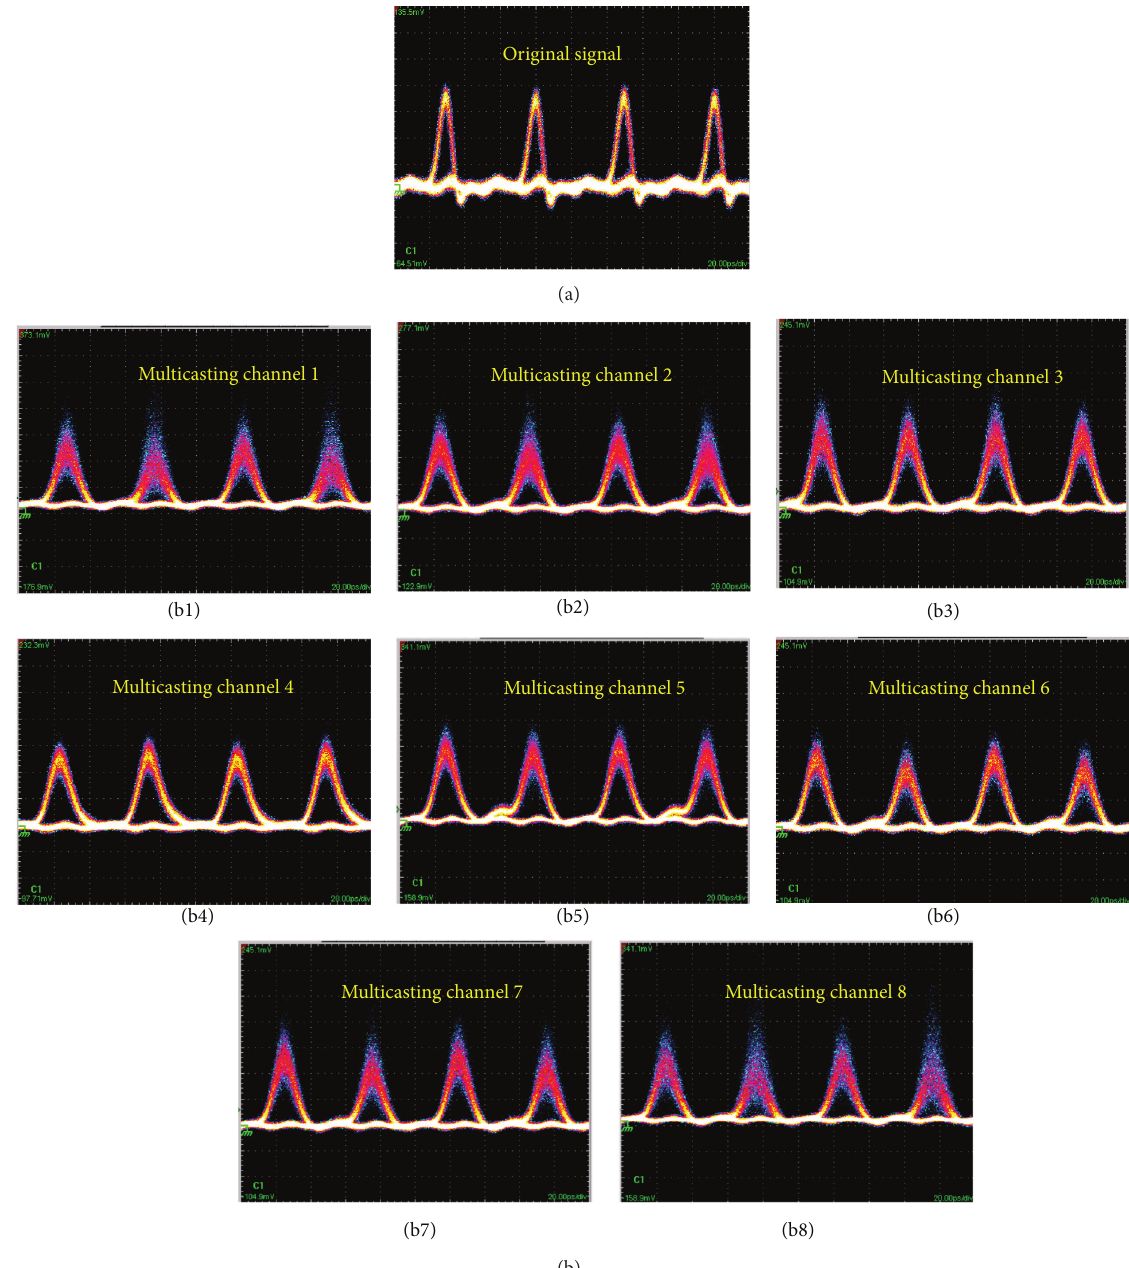
Figure 4: Eye diagrams of (a) the original input RZ signal and (b) the eight filtered multicasting channel signals. Time base: 20 ps/div.